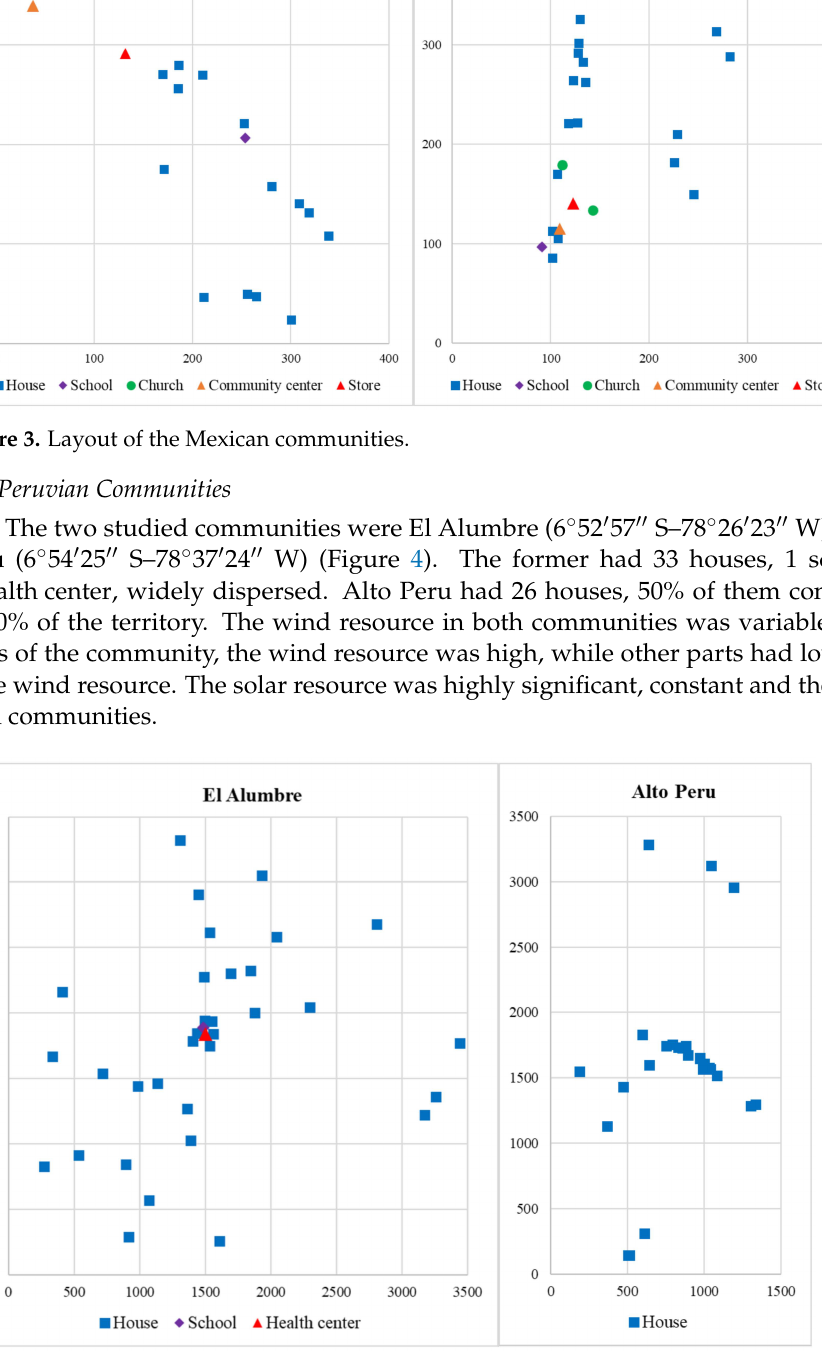
Figure 4. Layout of the Peruvian